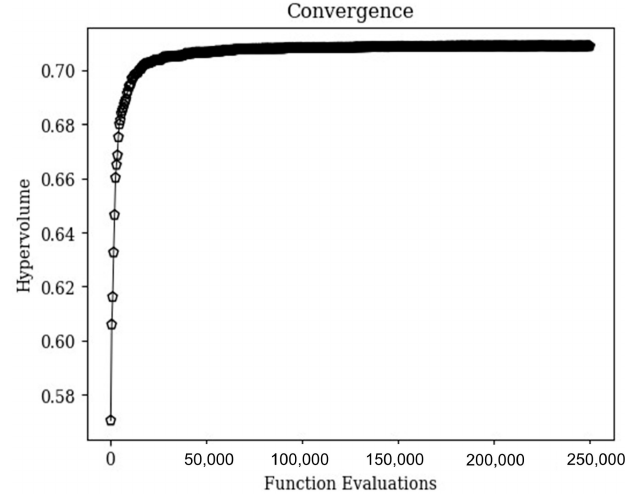
Figure 12. Hypervolume analysis of the considered